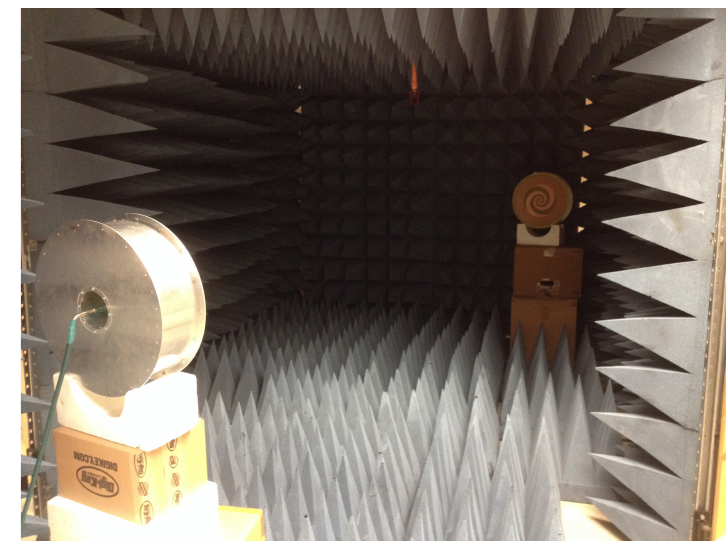
Figure 11. Antenna fidelity measurement setup.